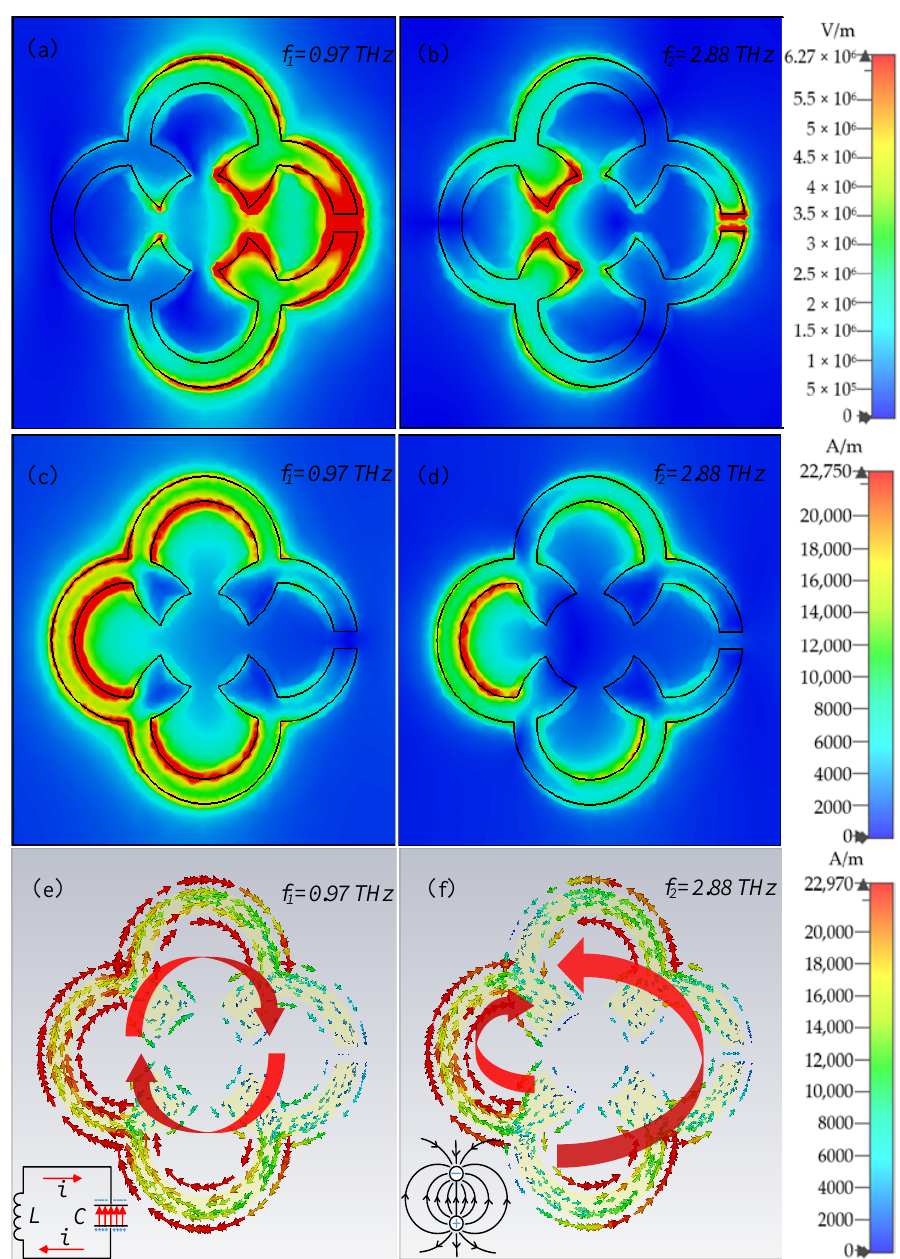
Figure 3. The electric field distribution at ( a ) f 1 and ( b ) f 2 ; the magnetic field distribution at ( c ) f 1 and ( d ) f 2 ; the current distribution at ( e ) f 1 (LC resonance) and ( f ) f 2 (dipole